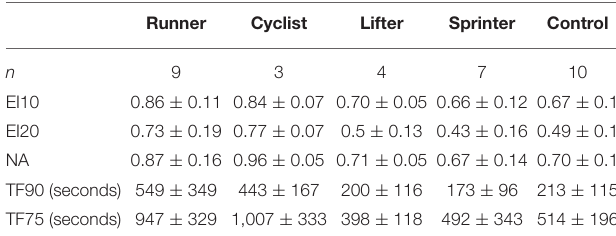
TABLE 1 | Mean ( ± SD) values of endurance indices (EI), normalized force area (NA), and time to fatigue (TF) metrics for